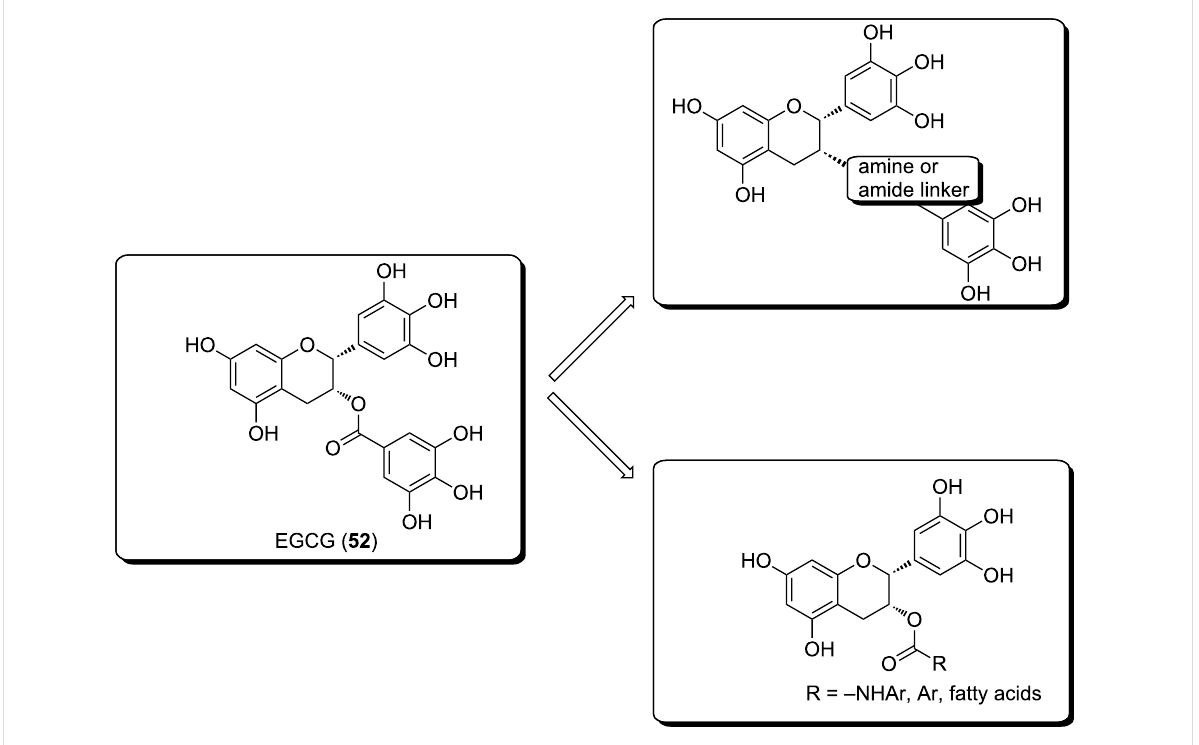
Figure 7: Analogs of ( − )-EGCG for the prevention of oxidation and improvement of the bioavailability of the compounds [67,70-72].